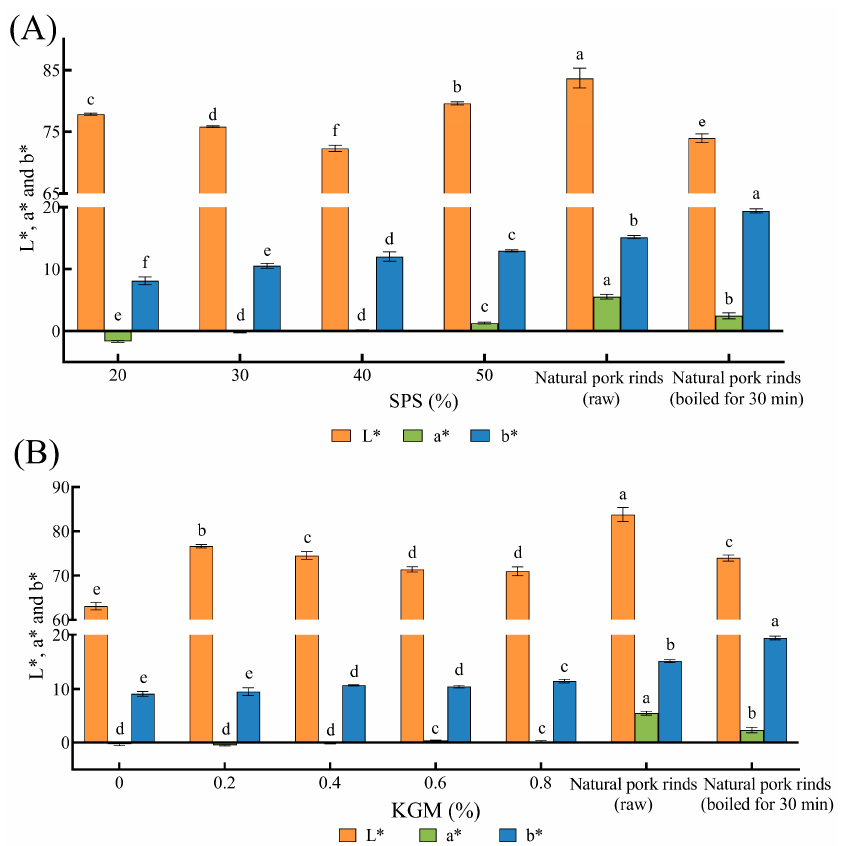
Figure 1. The color parameters of the plant-based pork rinds containing different SPS ( A ) and KGM ( B ) concentrations. Different lowercase letters (a–f) in the same color group denote significant differences ( p < 0.05).